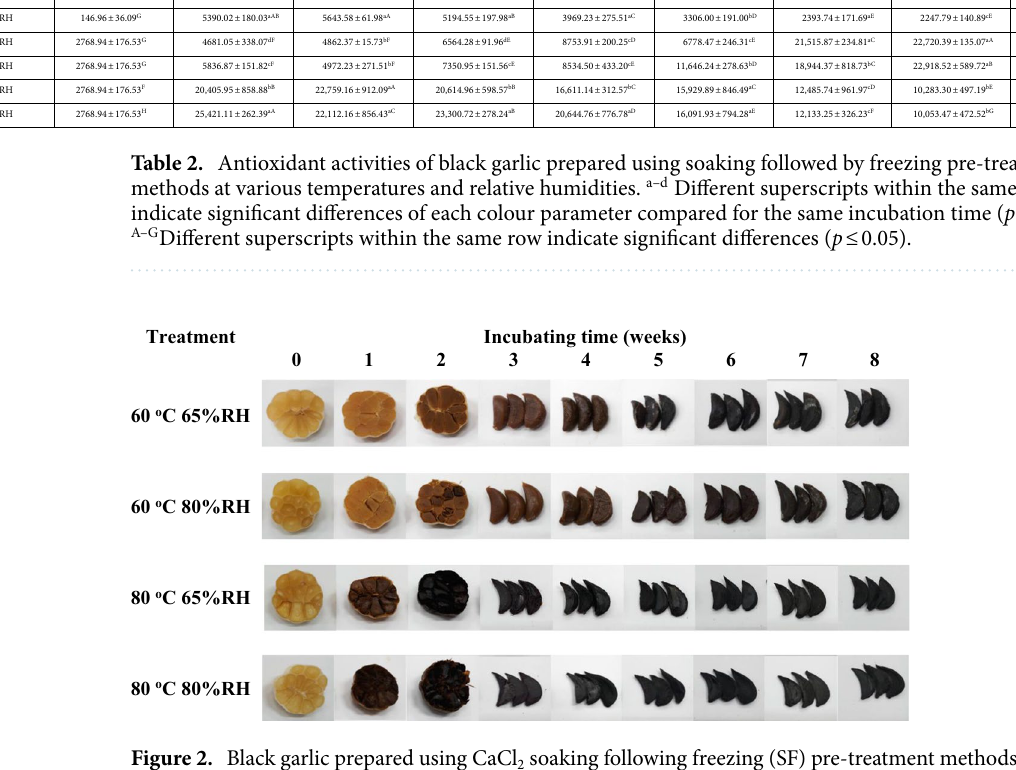
Figure 2. Black garlic prepared using CaCl 2 soaking following freezing (SF) pre-treatment methods at various temperatures and relative